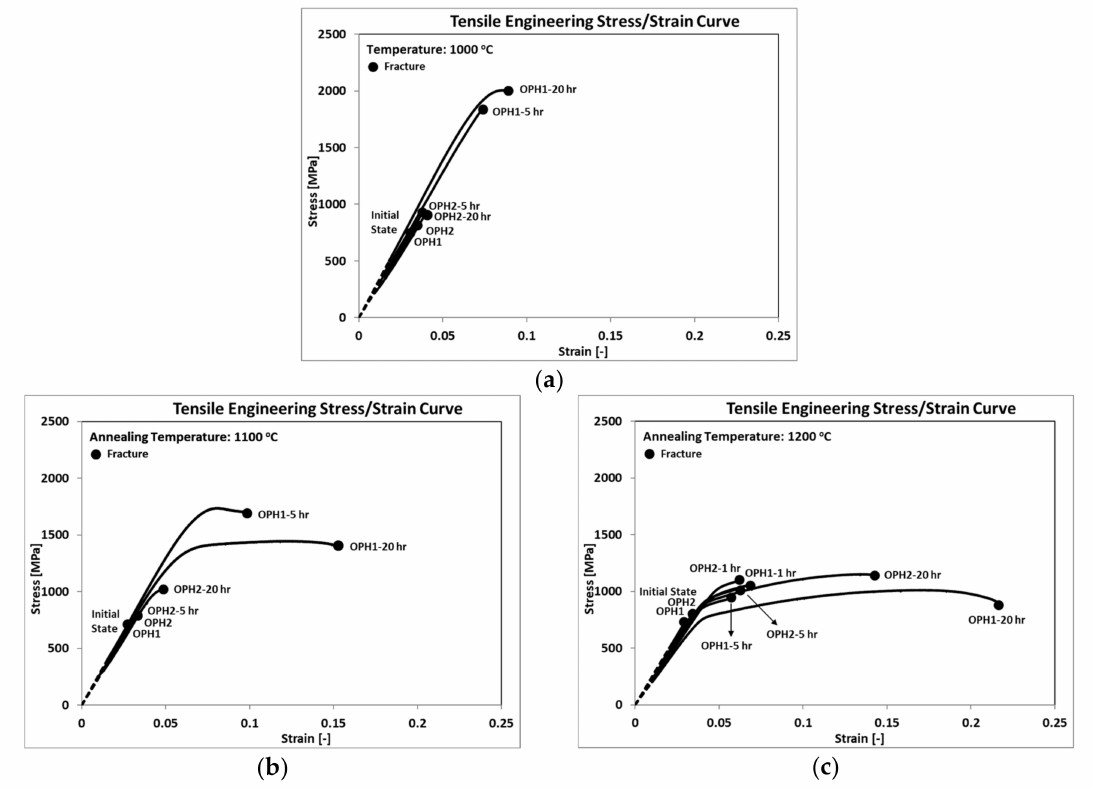
Figure 1. Flow curves after annealing at ( a ) 1000 ◦ C; ( b ) 1100 ◦ C; ( c ) 1200 ◦